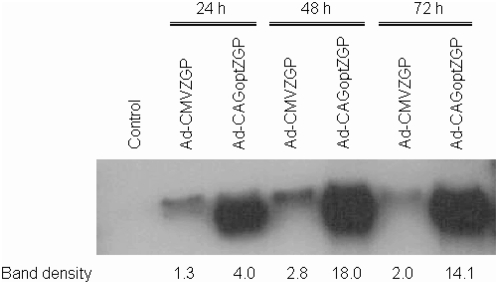
Western blot expression analysis of Ad-CMVZGP or Ad-CAGoptZGP.Proteins isolated from infected HEK 293 cells were separated by a 10% SDS PAGE then transferred to PVDF membrane. A mouse monoclonal anti-ZGP was used as the primary antibody and a goat anti-mouse horseradish peroxidase (HRP) conjugated antibody as the secondary antibody. 24, 48 and 72 hours indicate the time of total protein harvest post-infection. Band density corresponding to each lane is shown as determined by densitometry of the bands. The control represents untreated HEK 293 cells. An M.O.I. of 5 was used to infect the cells with either Ad-CMVZGP or Ad-CAGoptZGP for each time point. The preparation of Ad-CAGoptZGP or Ad-CMVZGP used had a non-infectious to infectious ratio of 73∶1or 19∶1 respectively.